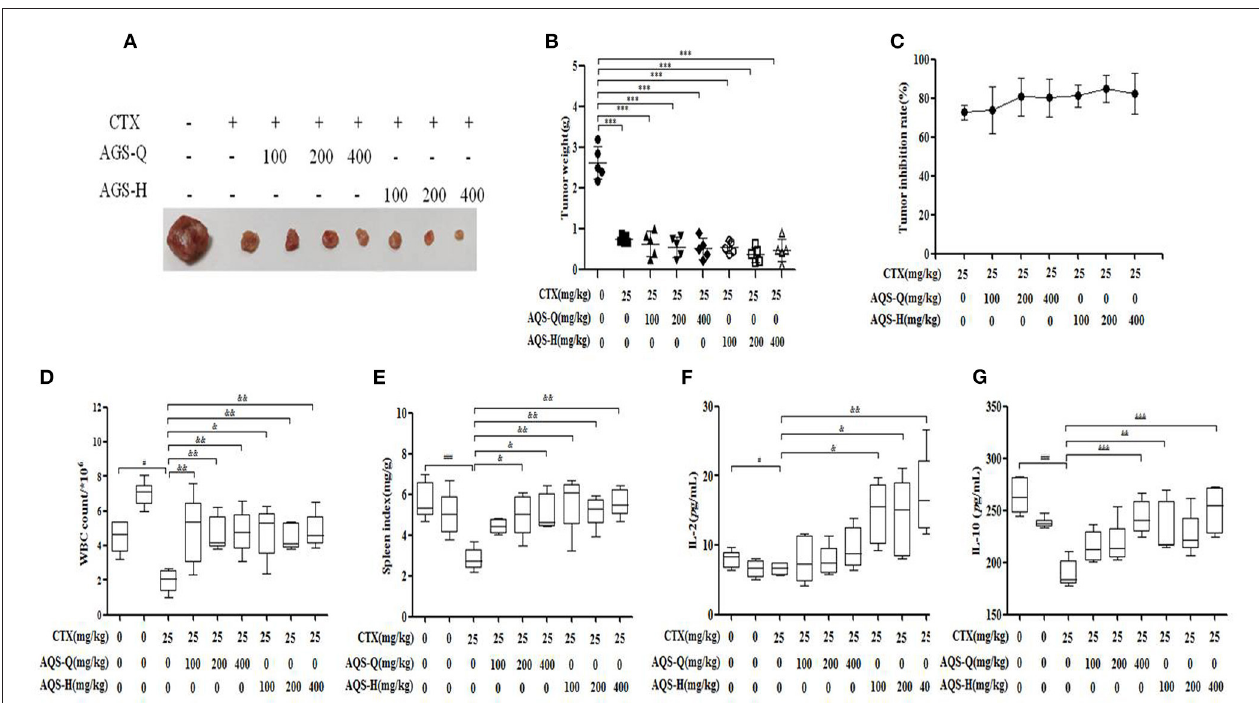
FIGURE 5 | Effects of AGS-Q or AGS-H synergistic CTX on tumor inhibition and immune indexes ( n = 8). (A) Tumor image. (B) Tumor weight. (C) Tumor inhibition rate. (D) The white blood cells count. (E) Spleen index. (F) The content of IL-2. (G) The content of IL-2. Values are presented as mean ± SD. vs. normal group, ## P < 0.01; vs. model group, *** P < 0.001; vs. CTX group, & P < 0.05, && P < 0.01, &&& P <